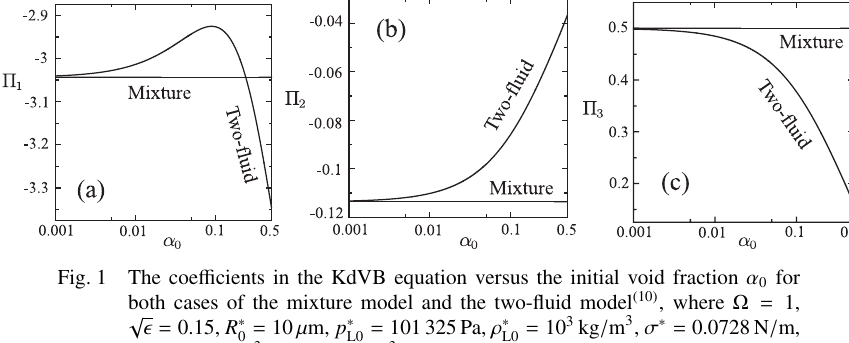
= 10 3 kg / m 3 , σ ∗ = 0 . 0728N / m, L0